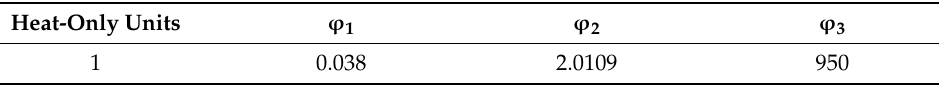
Table A3. Cost coefficients of the heat-only units.